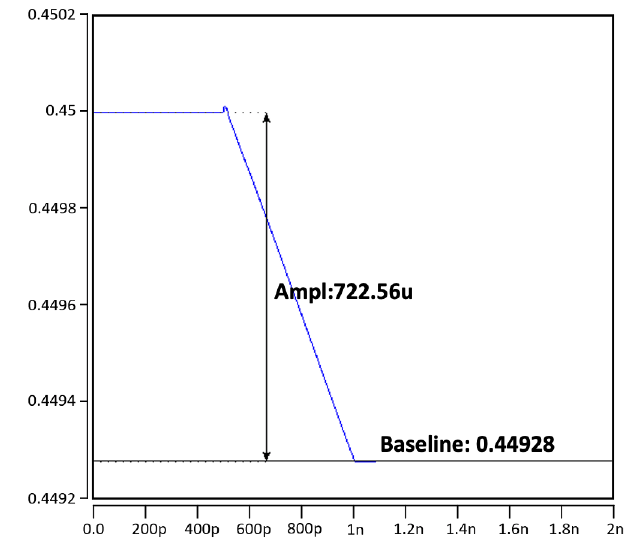
Figure 6. Discharging range with a single SRAM bit cell (0.72 mV).